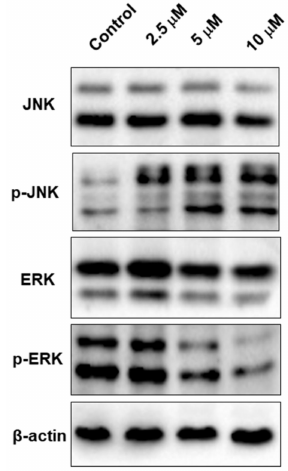
Figure 7. MDA-MB-231 cells were cultured with TSC-3C for 48 h, and the MAPK protein was analyzed by Western blot. β -Actin was used to normalize the protein